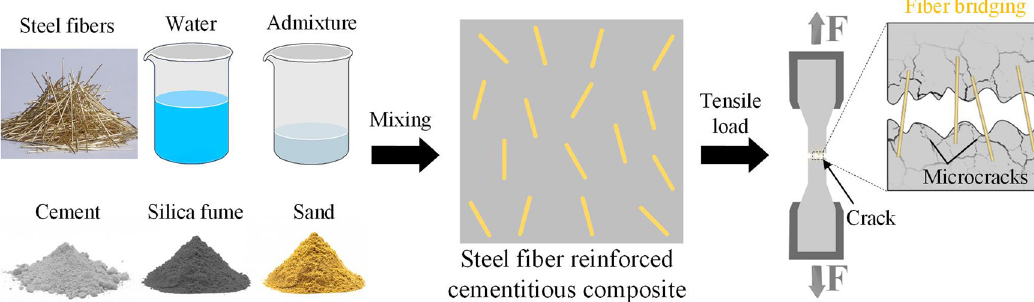
Figure 1: Schematic diagram of the bridging e ff ect of steel fi ber at interface under tensile load. The stress transfers from cementitious matrix to steel fi ber at interface, which retards the initiation and propagation of cracks in